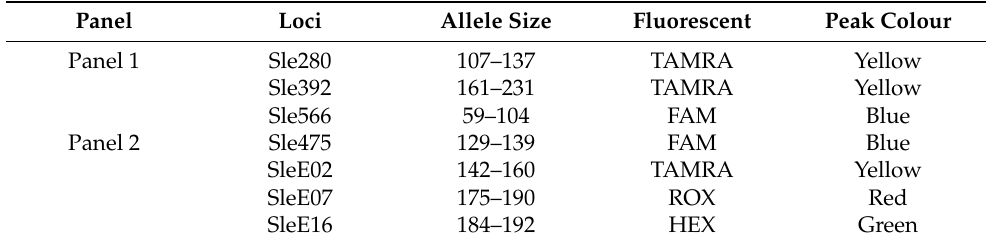
Table 2. Two panels consisting of seven microsatellite loci in fragment